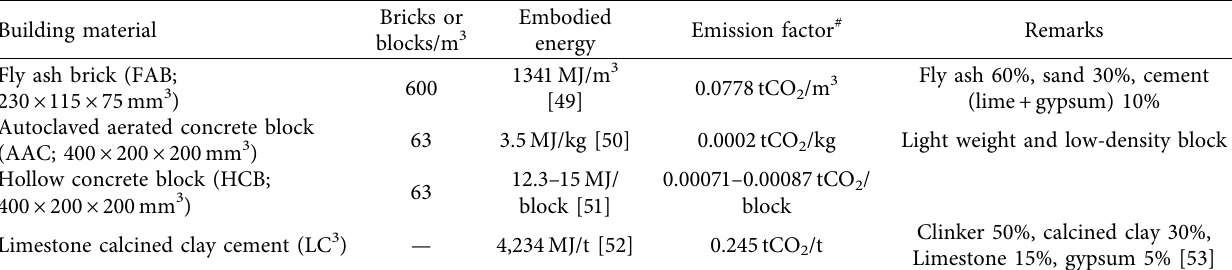
Table 5: Details of selected sustainable building materials.